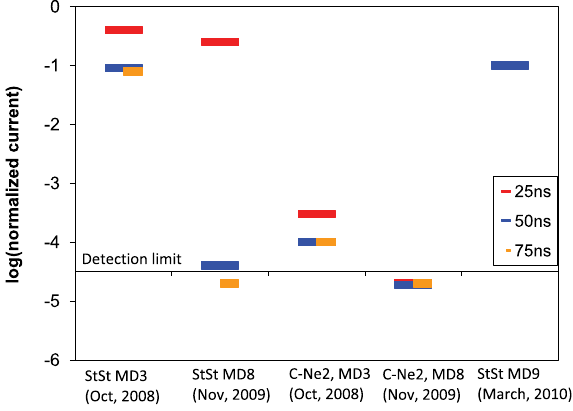
FIG. 9. E-cloud signal measured in the ECMs of StSt and carbon liners with the LHC-type beam of two batches of 72 bunches without